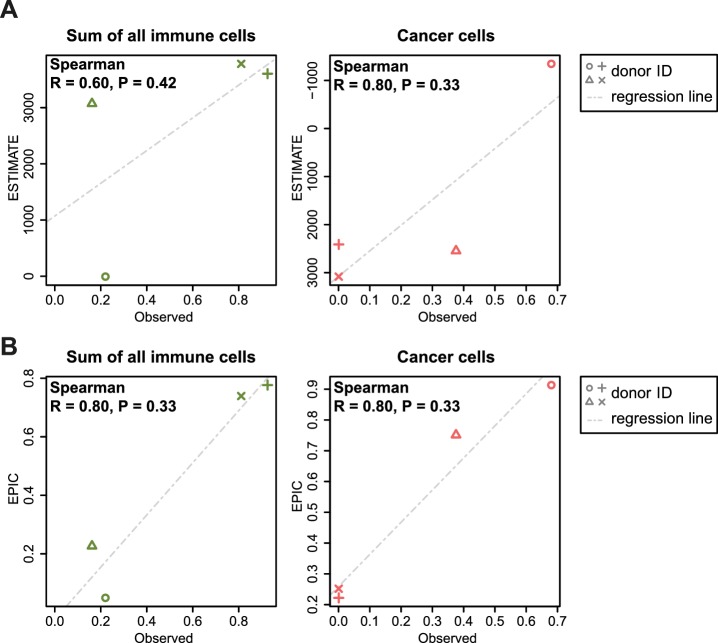
Comparison between ESTIMATE scores (A) and EPIC predictions (B) in our new flow cytometry dataset.The predictions are compared to the observed cell proportions. ESTIMATE returns a score of global immune infiltration and thus the sum of all observed immune cells has been taken for the comparison. The observed cancer cells correspond to the melan-A + cells. Correlations between observed fractions and predictions are based on Spearman correlations.